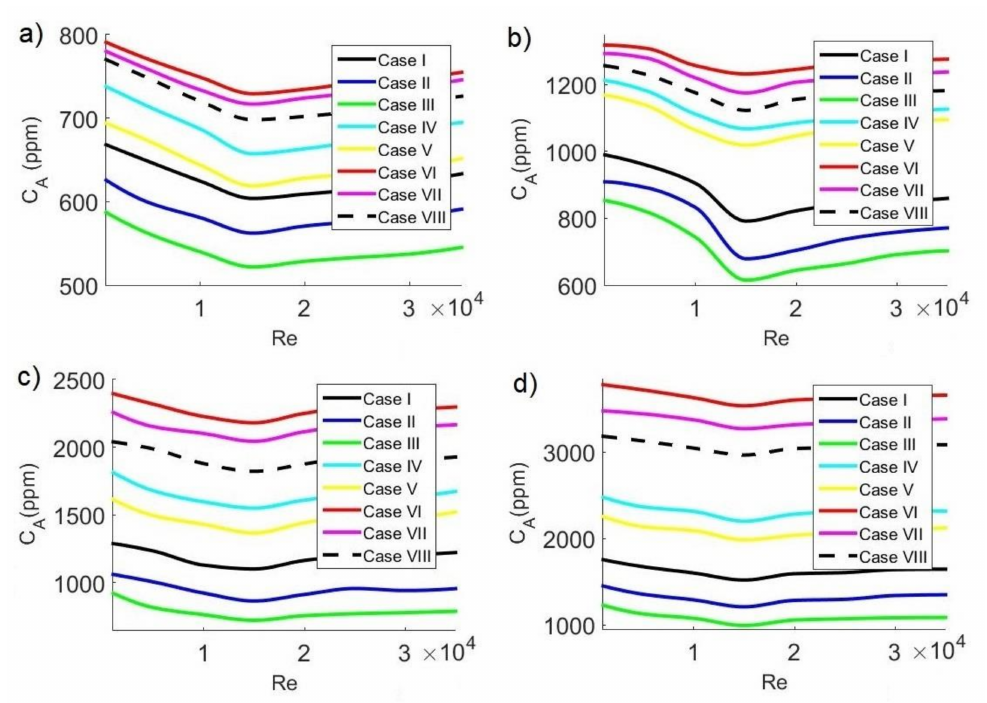
Figure 10. Average concentration of CO 2 in the classroom as a function of Reynolds number at